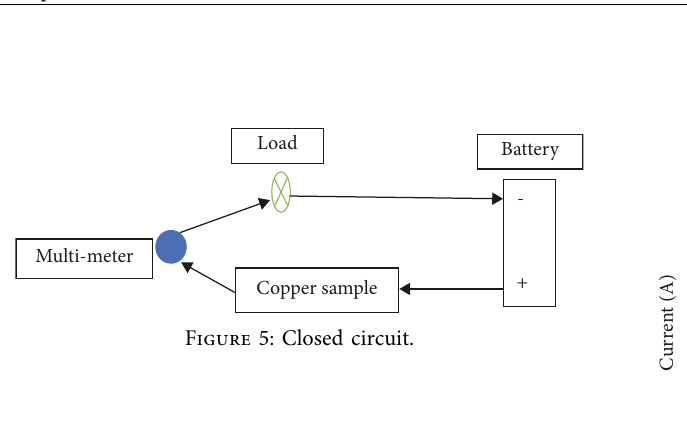
Figure 5: Closed circuit.